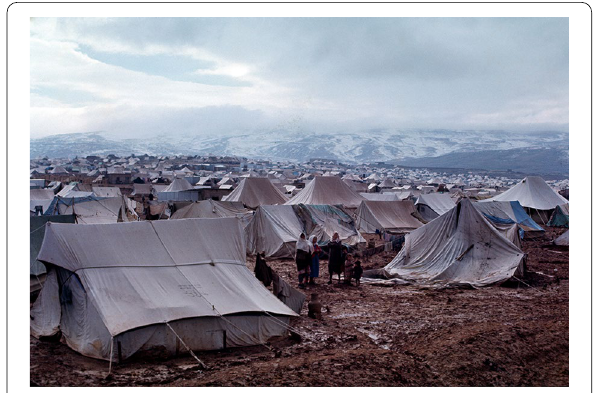
Fig. 8 Overview of Al Baqa’a emergency camp © 1969 UNRWA Archive Photo by Munir